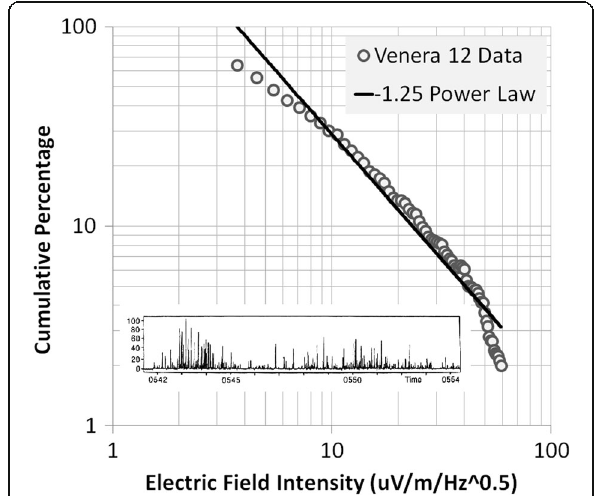
Fig. 8 Amplitude distribution of pulse heights (inset) recorded at a high data rate during part of the Venera 12 descent (see, e.g., Ksanfomality et al. 1983). About 30% of the time, the amplitude was at the noise level of ~ 5 uV/m/Hz 0.5 — spikes of ~ 100 occur less than 1% of the time. The data (analyzed here by digitizing the plotted figure) do not permit robust discrimination of a power law from a broken power law or an exponential; the single power law with an exponent of − 1.25 is shown as an example, although there is some hint of a steeper slope at the high end of the curve (right). The distribution arises either from an intrinsic amplitude distribution, or because discharges occur at a variety of ranges, or both. The distribution is also broadly consistent with the aggregate of results shown in Fig.